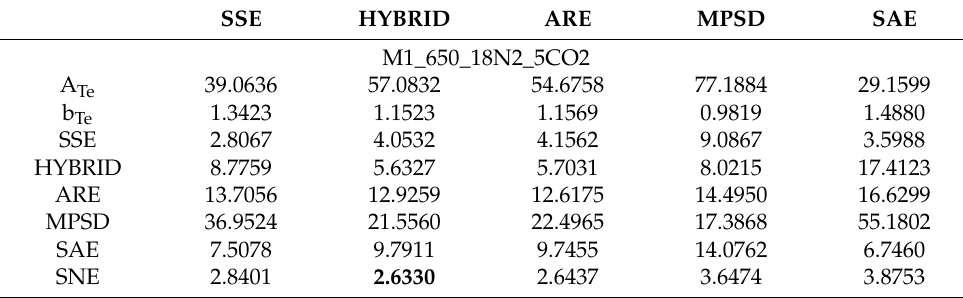
Table 9. Temkin isotherms constants with error analysis